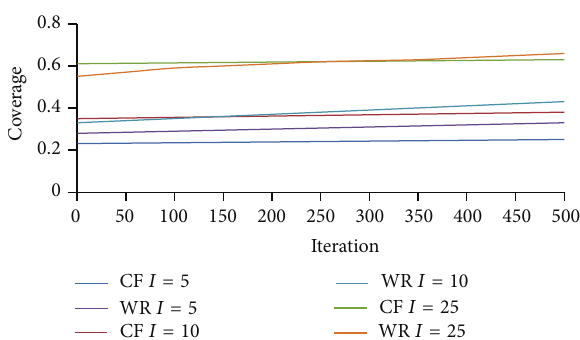
Figure 8: WebBluegillRecom-annealing system (WR) is compared to standard collaborative filtering (CF) system on 𝐹1 measure, 248 users.